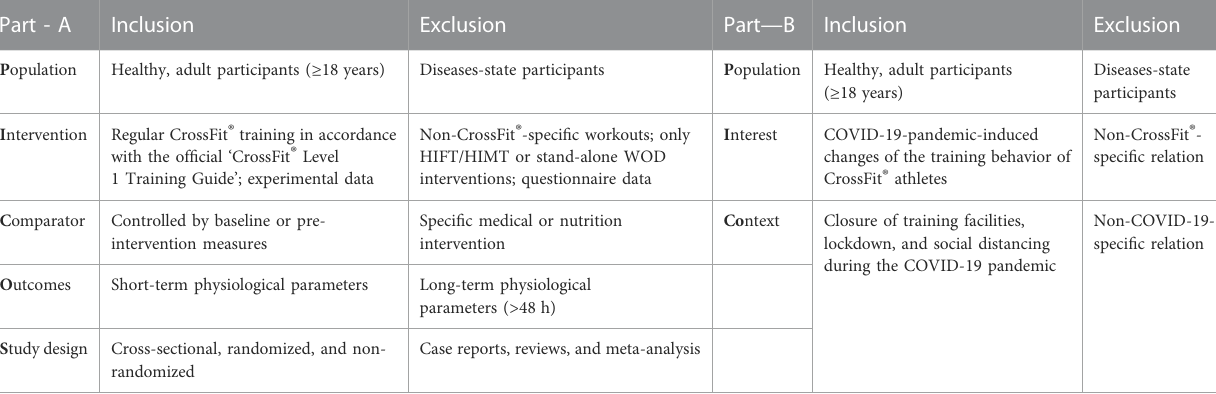
TABLE 1 Description of the inclusion and exclusion criteria according to the PICOS and PICo strategies (Stern et al., 2014; Amir-Behghadami and Janati, 2020). Part -